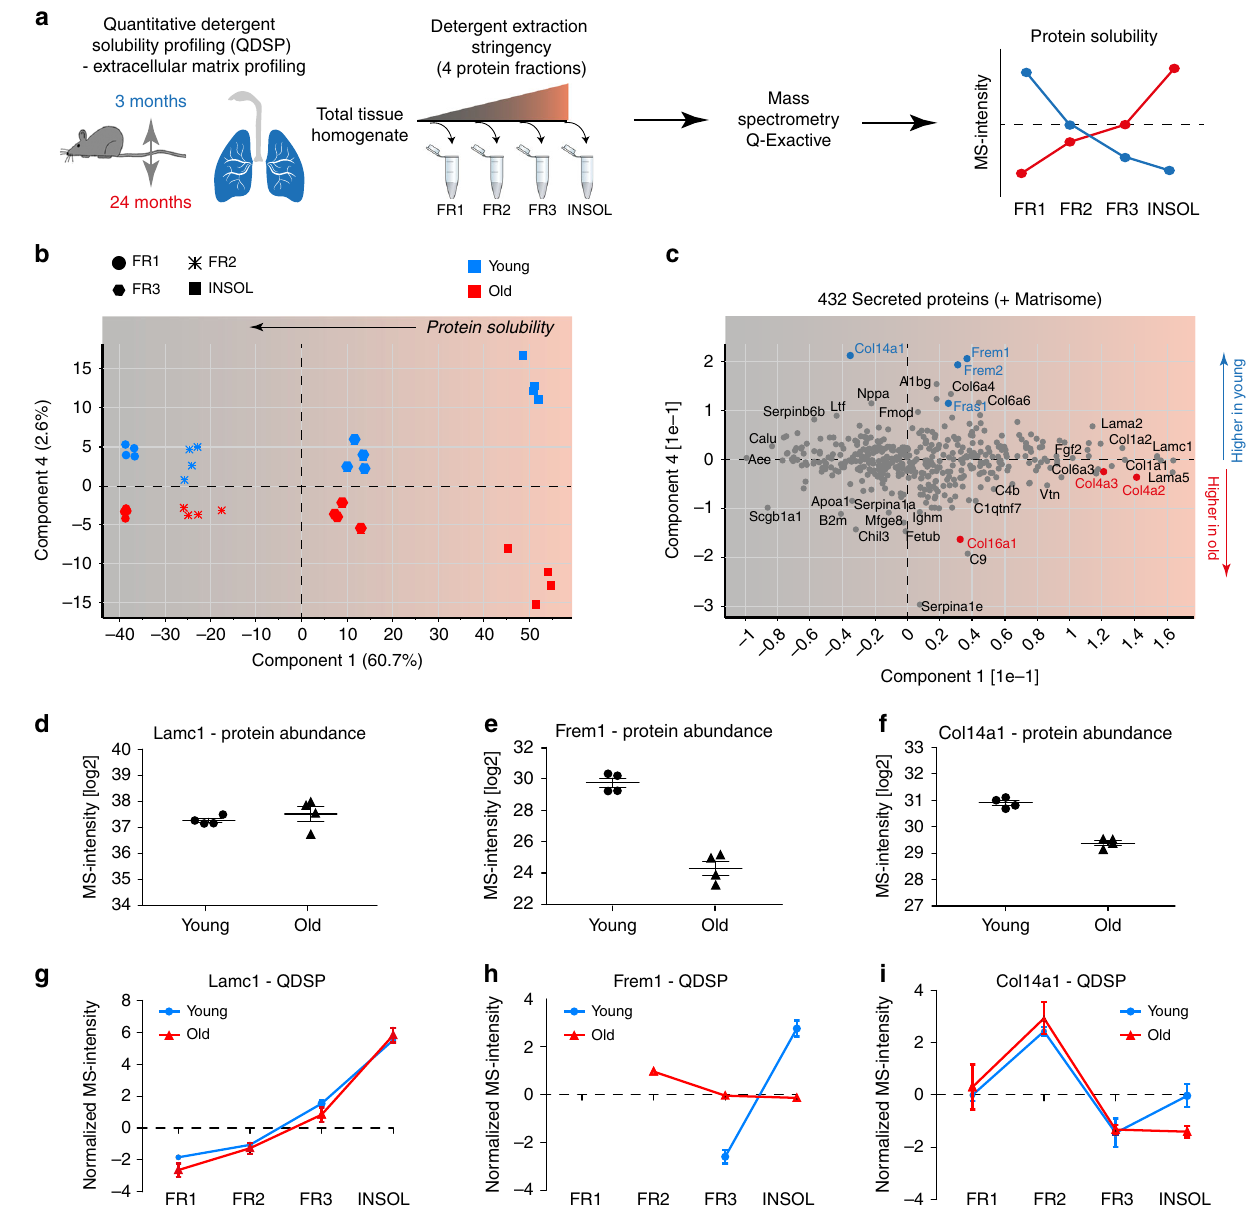
Fig. 6 Proteome-wide detergent solubility pro fi ling reveals changes in the extracellular matrix (ECM) architecture. a Experimental design — extraction of proteins from whole lung homogenates with increasing detergent stringency results in four distinct protein fractions, which are analyzed by mass spectrometry (MS). b The projections of a principal component analysis (PCA) of 432 proteins with the annotation ‘ secreted' in the Uniprot and/or Matrisome database separate the four protein fractions, indicated by symbol shape, in component 1 and the age groups, as indicated by color, in component 4. c The loadings of the PCA are shown. d – f Relative differences in MS intensity (abundance) of the indicated proteins. g – i The normalized MS intensity across the four protein fractions from differential detergent extraction highlights changes in protein solubility between young and old mice for the indicated proteins. Error bars represent the standard error of the means ( n =